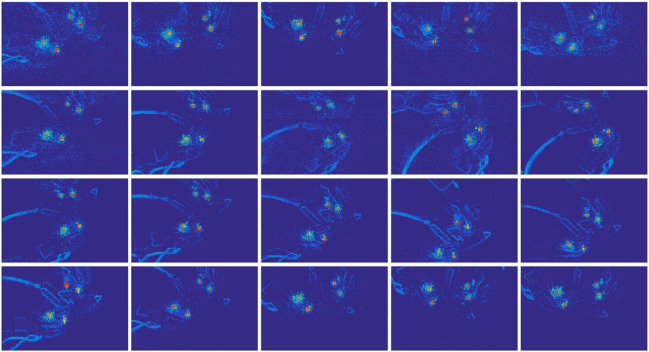
Tracking results of four LED markers along time. The markers are used to define the bad grasping position of a glue gun. Each subplot demonstrates the heat map of events recorded in the cycle window. The heat maps update in every cycle (1 ms), but they are only plotted every 250 ms for the demonstration here. The four red stars in each subplot represent the tracked marker positions.